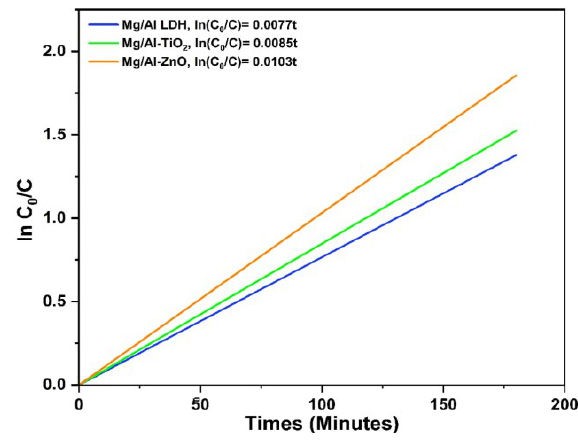
Fig. 6. CR photodegradation rate constant curve